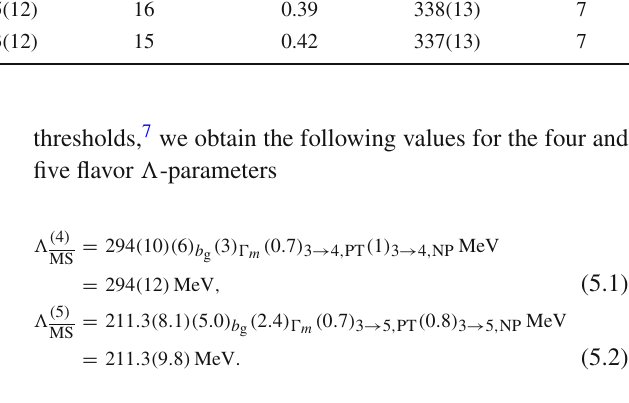
Fig. 3 Values for (cid:3) ( 3 ) Table 3 ( c = 0 . 36) and their extrapolation M → ∞ using